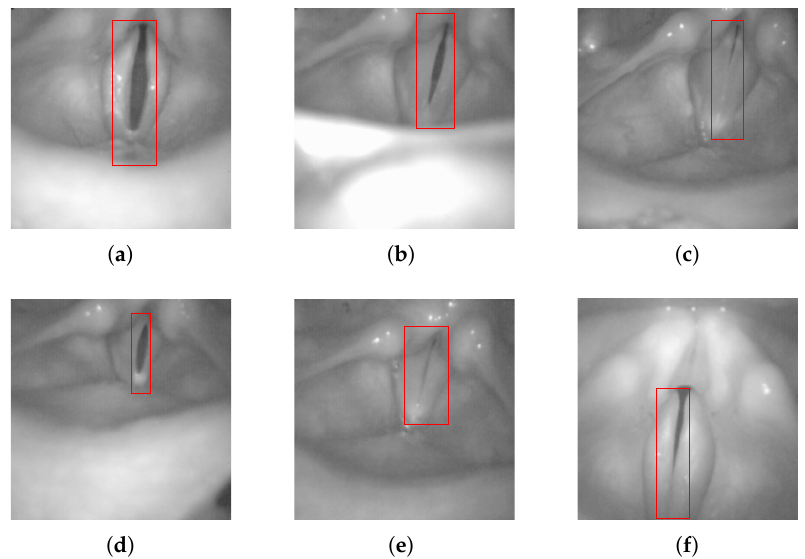
Figure 8. Automatic ROI detection of six different HSV computed based on [94,107]. The image in (f) illustrates a minor problem in the detection of the ROI in the posterior